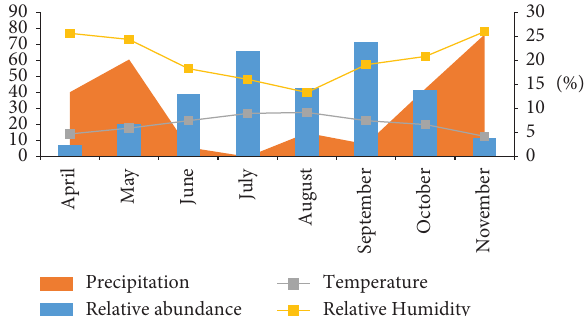
Figure 3: Representation of the relative abundance of sandfies and variation of the monthly temperature, relative humidity, and precipitation in Meknes